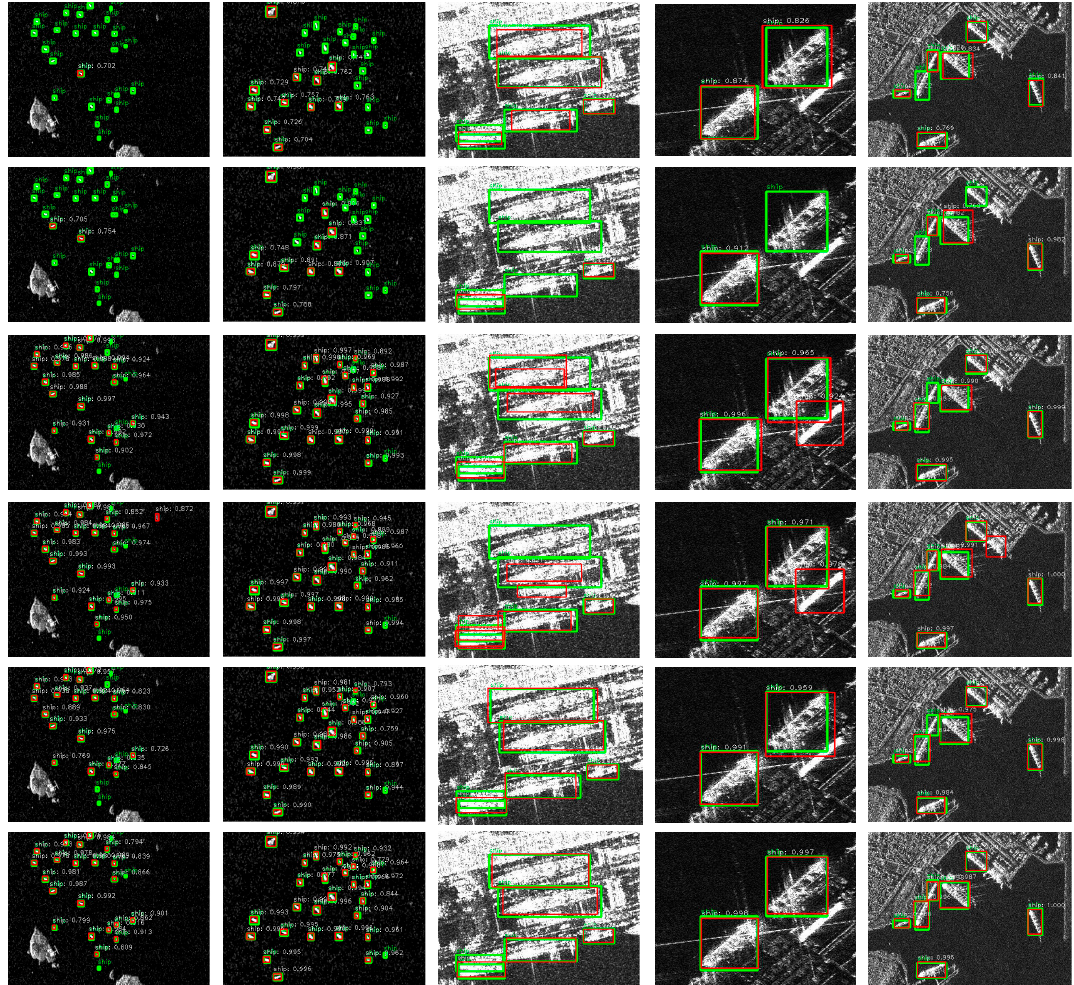
Figure 12. Ship detection results of the different models in the SSDD dataset. Row 1 is the result of YOLOv2; Row 2 is the result of RetinaNet; Row 3 is the result of Faster R-CNN; Row 4 is the result of Mask R-CNN; Row 5 is the result of Cascade R-CNN; Row 6 is the result of HR-SDNet. Column 1 and Column 2 is the offshore scenes; Others are the inshore scenes. Red boxes denote predicted results; green boxes denote ground truth. Table 5. Comparison with state-of-the-art Single-Model Detectors in the SSDD Data Set.